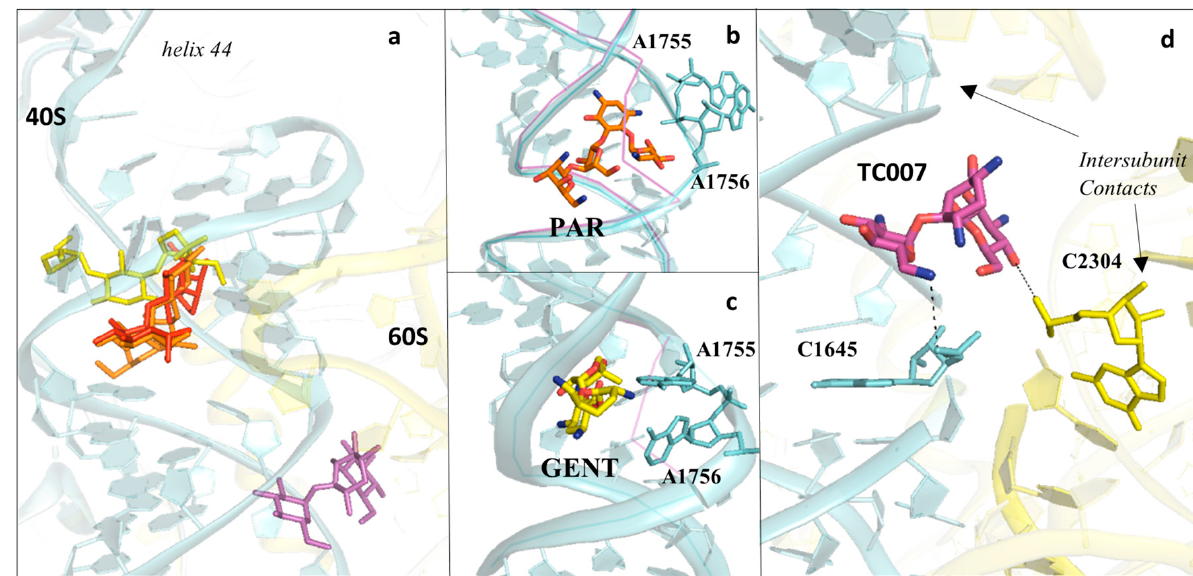
Figure 7. Aminoglycosides bind preferentially to the DC of the eukaryotic ribosome. ( a ) Overview of aminoglycosides binding in correspondence of helix 44 (h44) of the eukaryotic SSU. Paromomycin (PAR) in orange (PDB: 5NDV), geneticin (G418) in red (PDB: 5NDG), gentamycin (GENT) in yellow (PDB: 5OBM), TC007 in violet (PDB: 5NDJ); ( b ) PAR binds within the minor groove of h44 and promotes “flip-out” of the two conserved adenines (A1755/A1756) towards the mRNA channel; ( c ) GENT binds to h44, but docks in a different way compared to PAR, and induces only partial extrusion of the decoding residues. Vacant ribosome (PDB: 4V88) aligned and shown as a purple line for evidencing the conformational change of the minor groove of h44 upon drug binding; ( d ) zoom-in and details of interaction for the aminoglycoside TC007. TC007 directly contacts both LSU and SSU, establishing hydrogen bonds with rRNA residues of the 25S and 18S at a specific intersubunit bridge